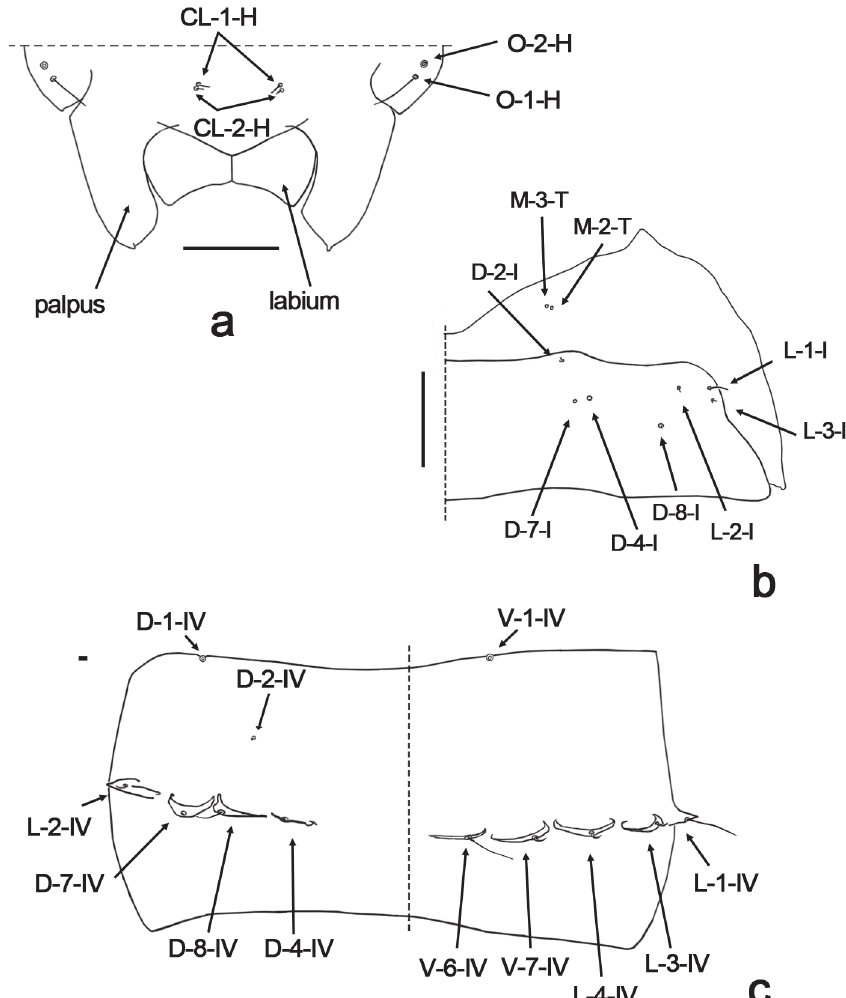
Figure 4a-c - Dasyhelea mediomunda Minaya, female pupa, a , clypeal/ labral and ocular sensilla (details, ventral view); b - metathoracics and first abdominal segment chaetotaxy; c - fourth abdominal segment chaetotaxy. Clypeal/labrals sensilla (CL-1-H, CL-2-H); dorsal sensilla of first abdominal segment (D-2-I, D-4-I, D-7-I, D-8-I); dorsal sensilla of segment 4 (D-1-IV, D-2-IV, D-4-IV, D- 7-IV, D-8-IV); lateral sensilla of first abdominal segment (L-1-I, L-2-I, L-3-I); lateral sensilla of segment 4 (L-1-IV, L-2-IV, L-3-IV, L-4-IV); methatoracic sensilla (M-2-T, M-3-T); ocular sensilla (O-1-H, 0-2-H); ventral sensilla of segment 4 (V-1-IV, V-6-IV, An Acad Bras Cienc (2016) 88 (3 Suppl.)